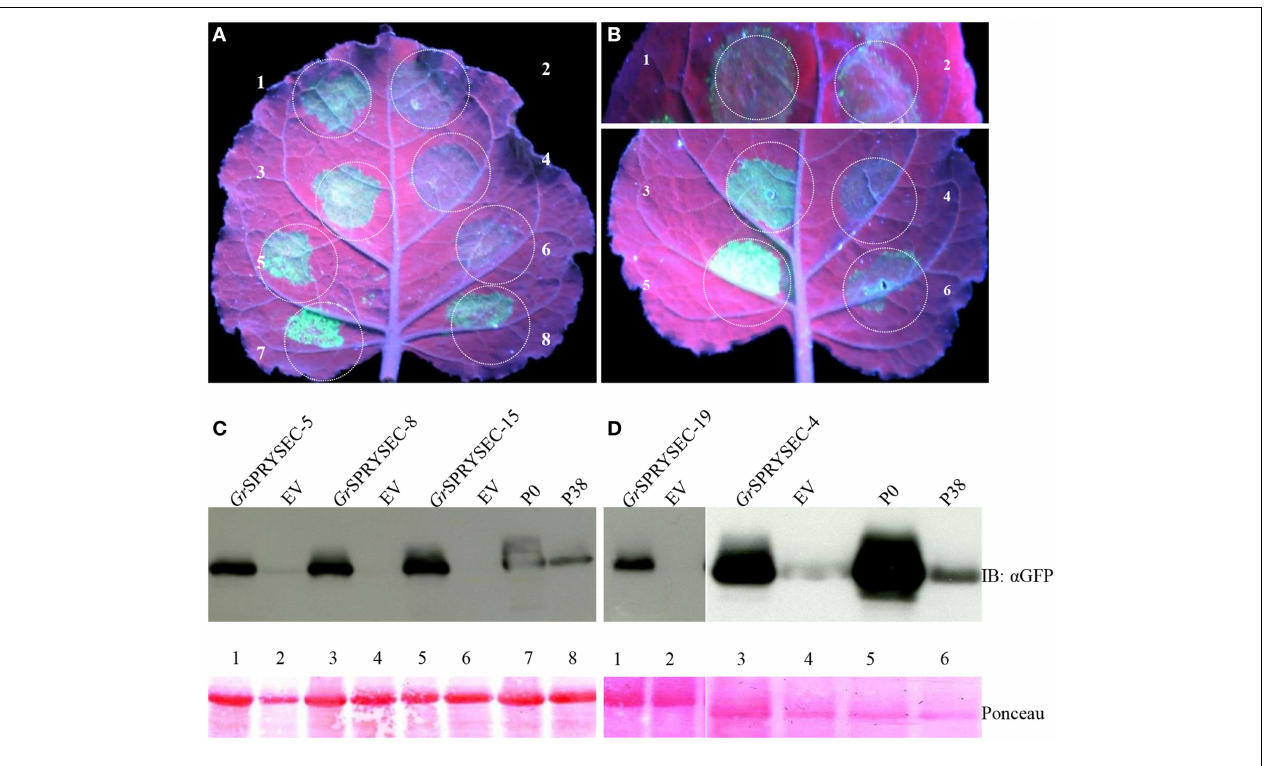
6, P38. GFP expression was visualized under UV illumination at 4 DPI. (C,D) Anti GFP immune blotting was performed on total protein samples taken at 4 DPI from N. benthamiana leaf patches co-expressing the combinations of constructs described in (A,B) . The number on the blot corresponds to the number on the leaf above each blot. Ponceau staining (lower panel) was used to show equal